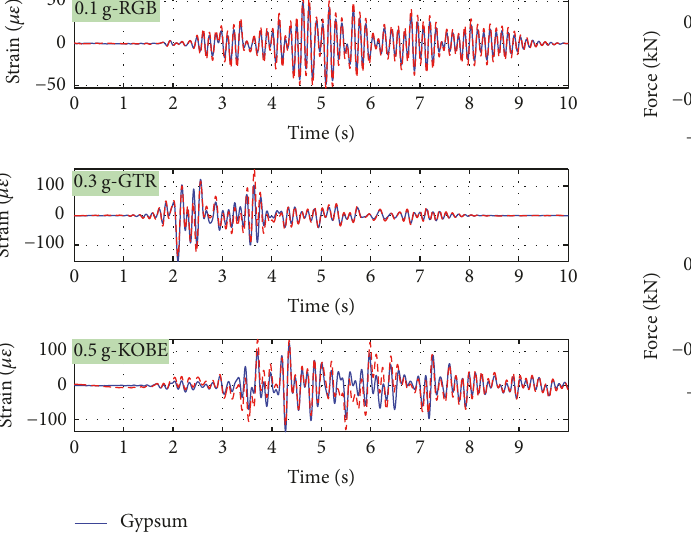
Figure 15: Measured pretension in slab-to-shaking table anchors.